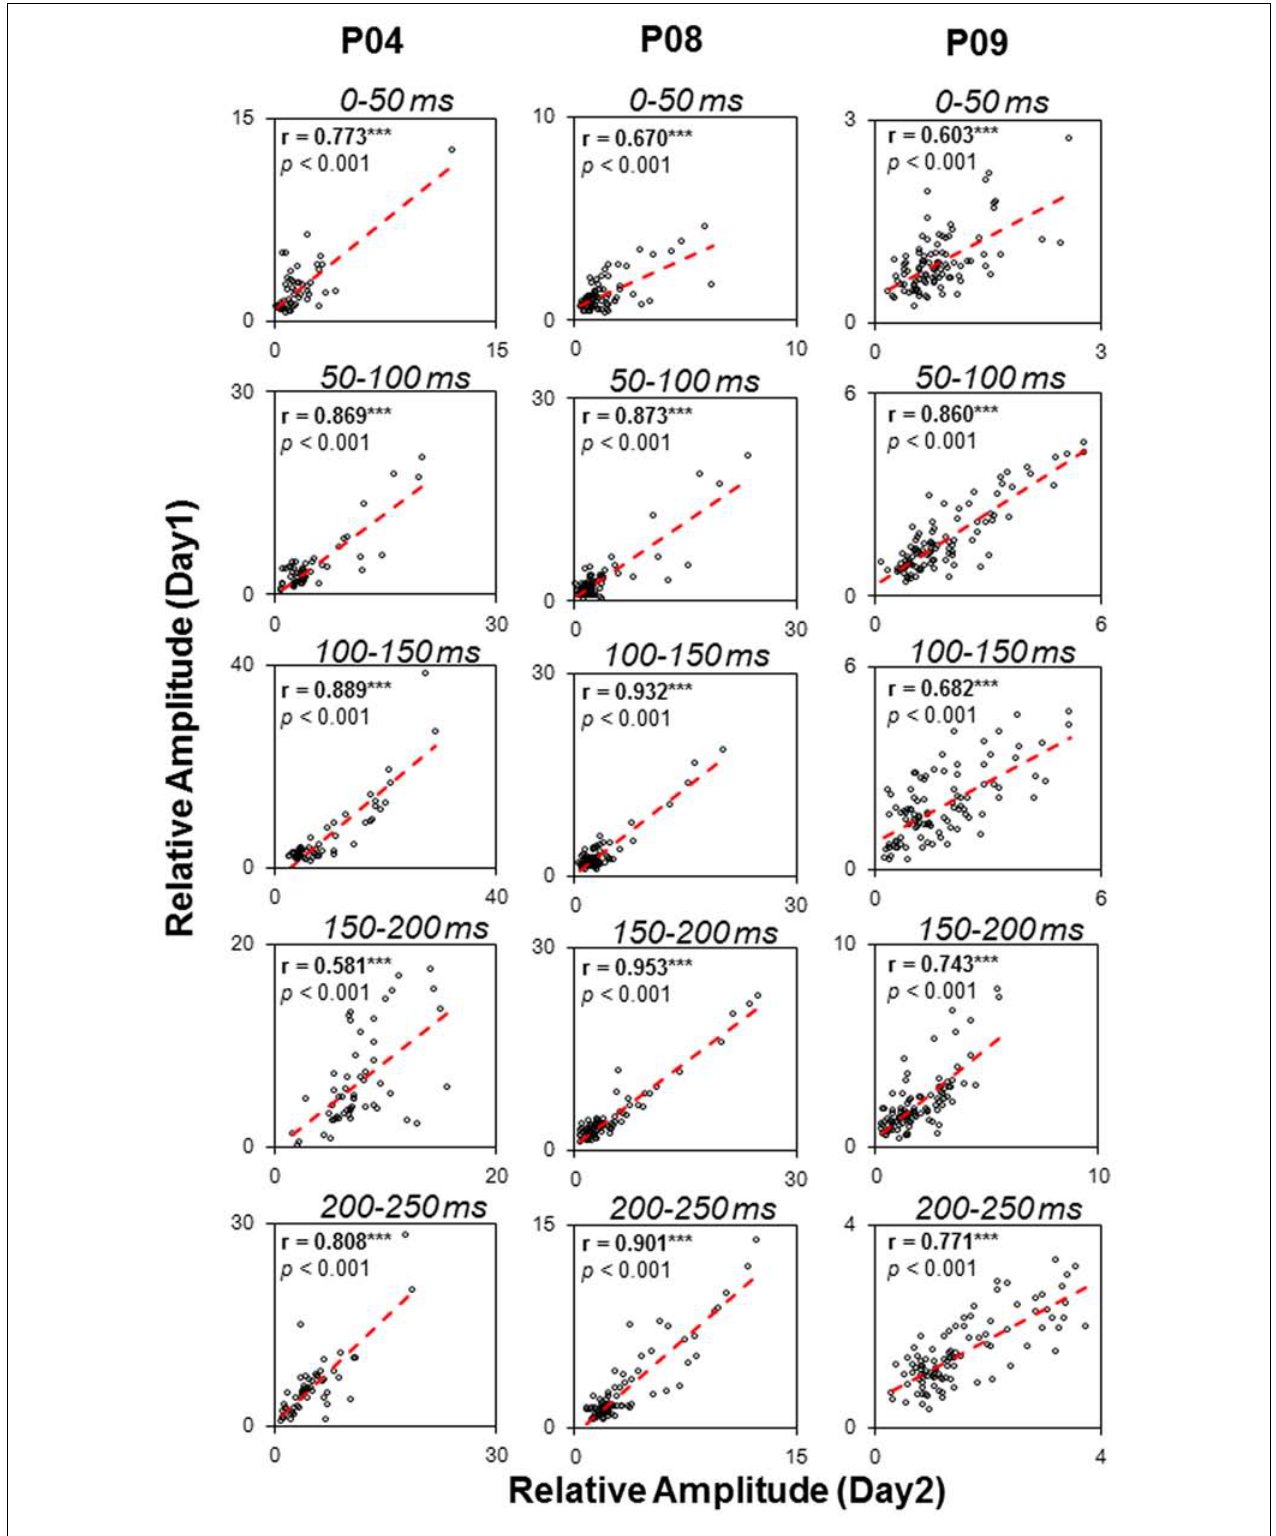
FIGURE 8 | Test-retest reliability (Pearson correlation tests) of noise-burst-evoked activities in three participants (P04, P08, and P09). ∗∗∗ p < 0.001.